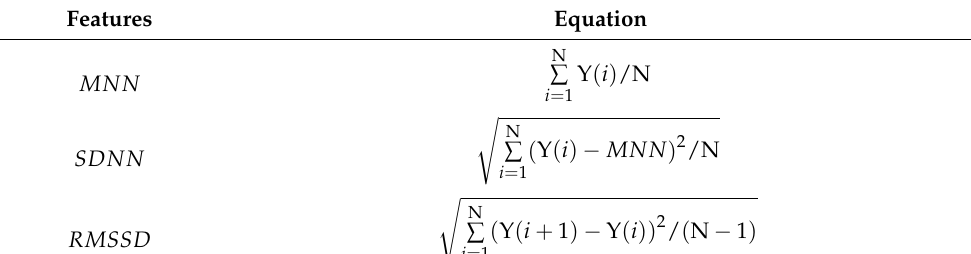
Table 3. Seven HRV